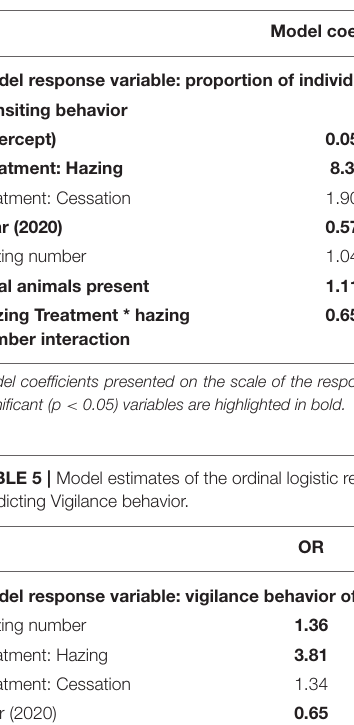
TABLE 4 | Generalized linear model for sea lion foraging behavior (proportion of individuals foraging vs. traveling) during observation.